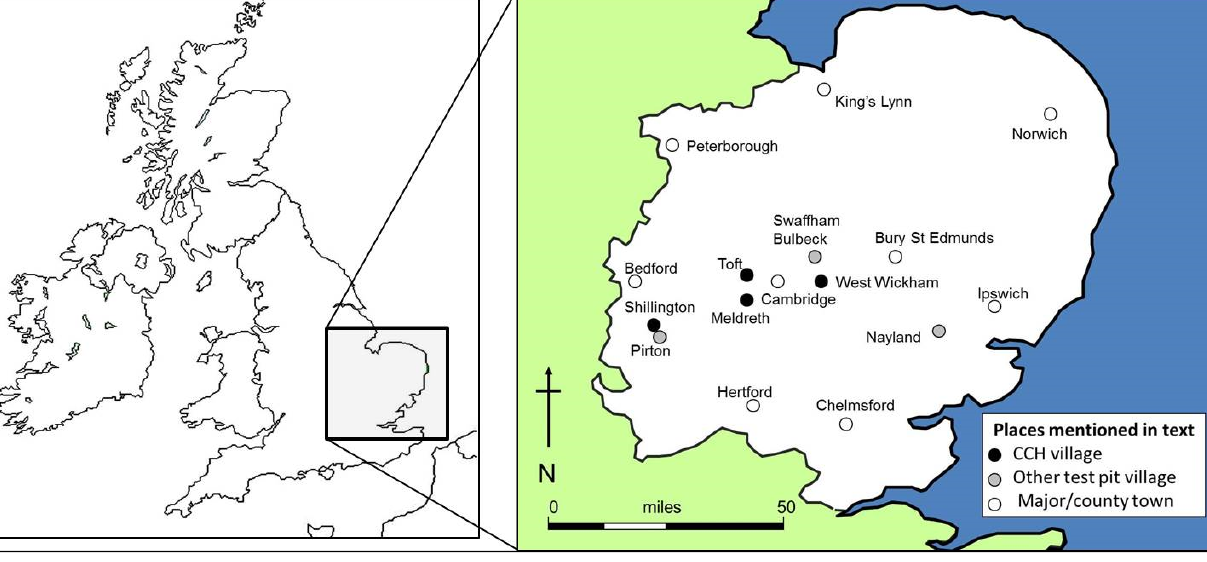
Figure 1. Map of the British Isles showing places mentioned in the